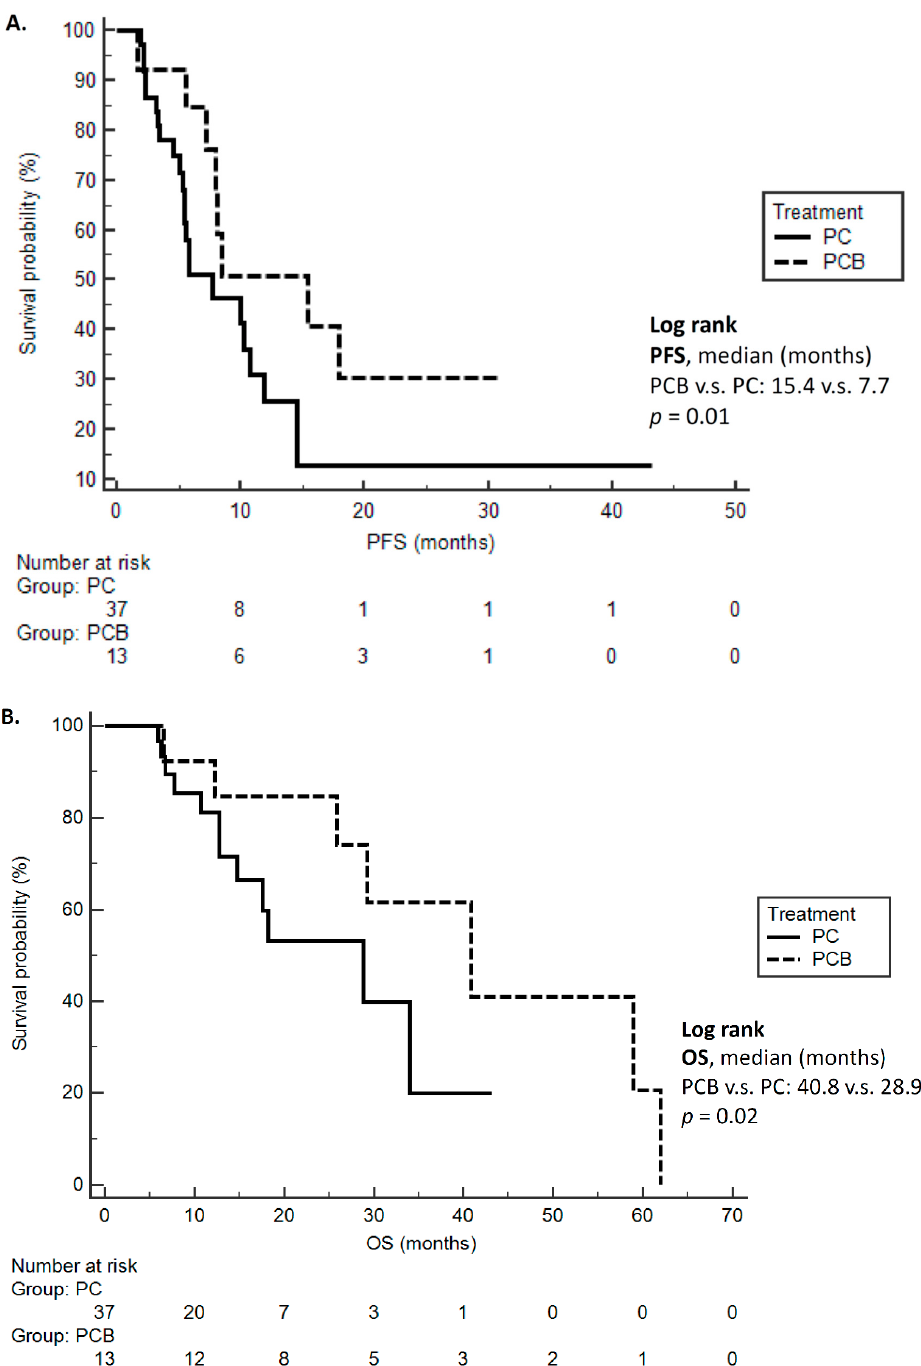
Figure 1. Kaplan–Meier survival analysis illustrated chemotherapy combination affects ( A ) progression-free survival (PFS) and ( B ) overall survival (OS). Non-small cell lung cancer (NSCLC) patients treated with bevacizumab-combined pemetrexed/platinum doublet chemotherapy (PCB) had significant longer PFS and OS compared to pemetrexed/platinum doublet (PC) (PCB vs. PC, PFS, median, 15.4 vs. 7.7 months, p = 0.01; OS, median, 40.8 vs. 28.9, months, p = 0.02).